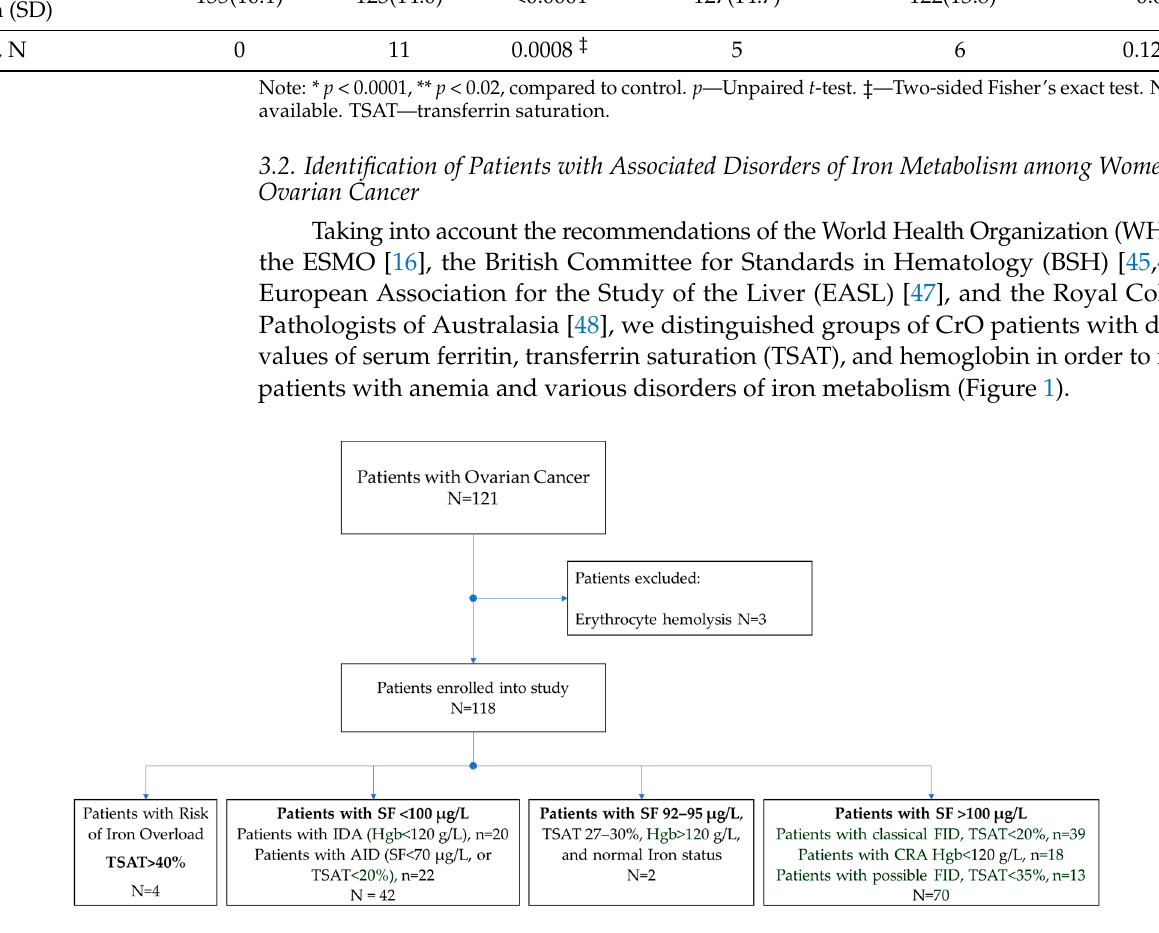
Figure 1. Flow diagram of CrO patients. SF—serum ferritin, TSAT—transferrin saturation, Hgm— hemoglobin, IDA—iron deficiency anemia, AID—absolute iron deficiency, FID—functional iron deficiency, CRA—cancer-related anemia.